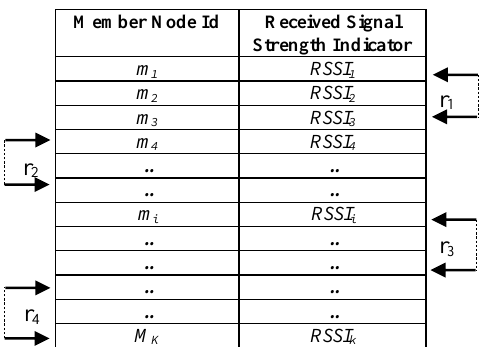
Figure 7. Segmentation architecture of member nodes inside a sector. Table 4. Member table of a SH